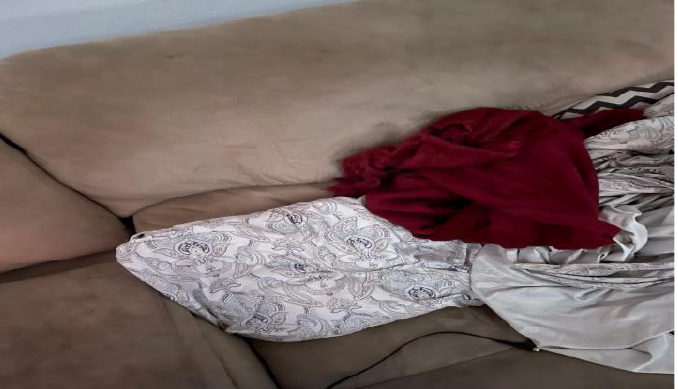
Figure 10. Couch surfing after family disownment.